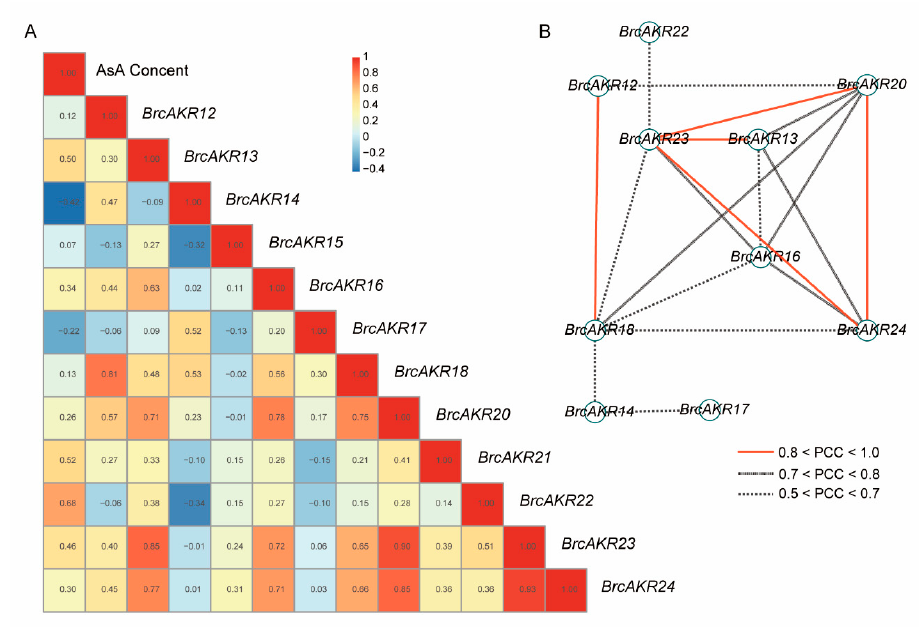
Figure 6. Effect of light on the ascorbic acid (AsA) level and the expression patterns of aldo-keto reductases ( AKR ) genes in Pak-choi leaves. ( A ) The bar chart indicates the AsA levels. ( B ) Line charts: transcript levels of AKR genes. For each sample, the transcript levels were normalized with those of actin (control). Data are the mean values ± SD of three individual experiments ( n = 3).